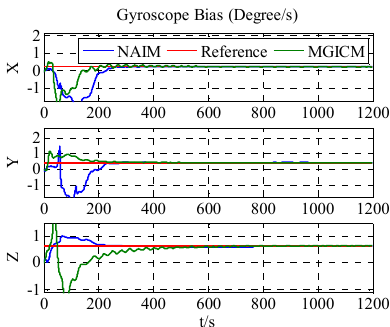
Figure 4 . Estimation result of magnetometer bias. MGICM: magnetometer and gyroscope integrated calibration method; NAIM: normal attitude-independent method.